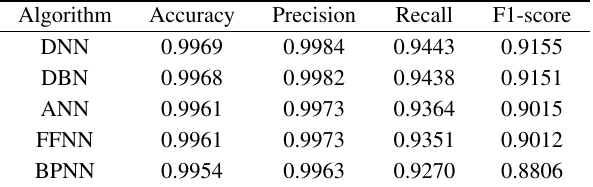
Table 5 Performance of remdesivir drug interaction with SARS-CoV-2 virus over Indian datasets.